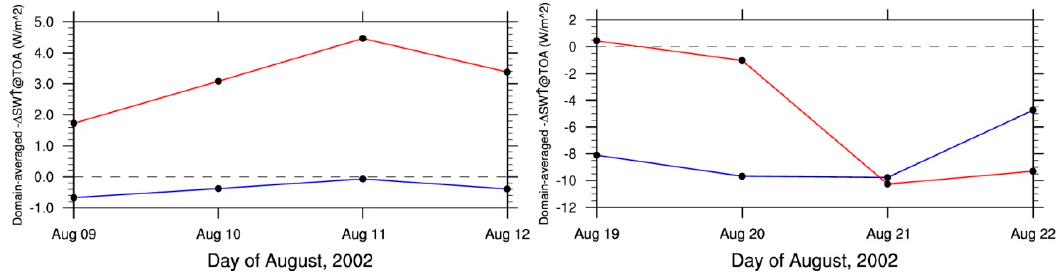
Figure 12. ( a ) the time series of the total aerosol radiative effect (TARE, red lines) and ( b ) the direct aerosol radiative effect (DARE, blue lines) for FP1 and FP2. TARE and DARE are defined in the text.